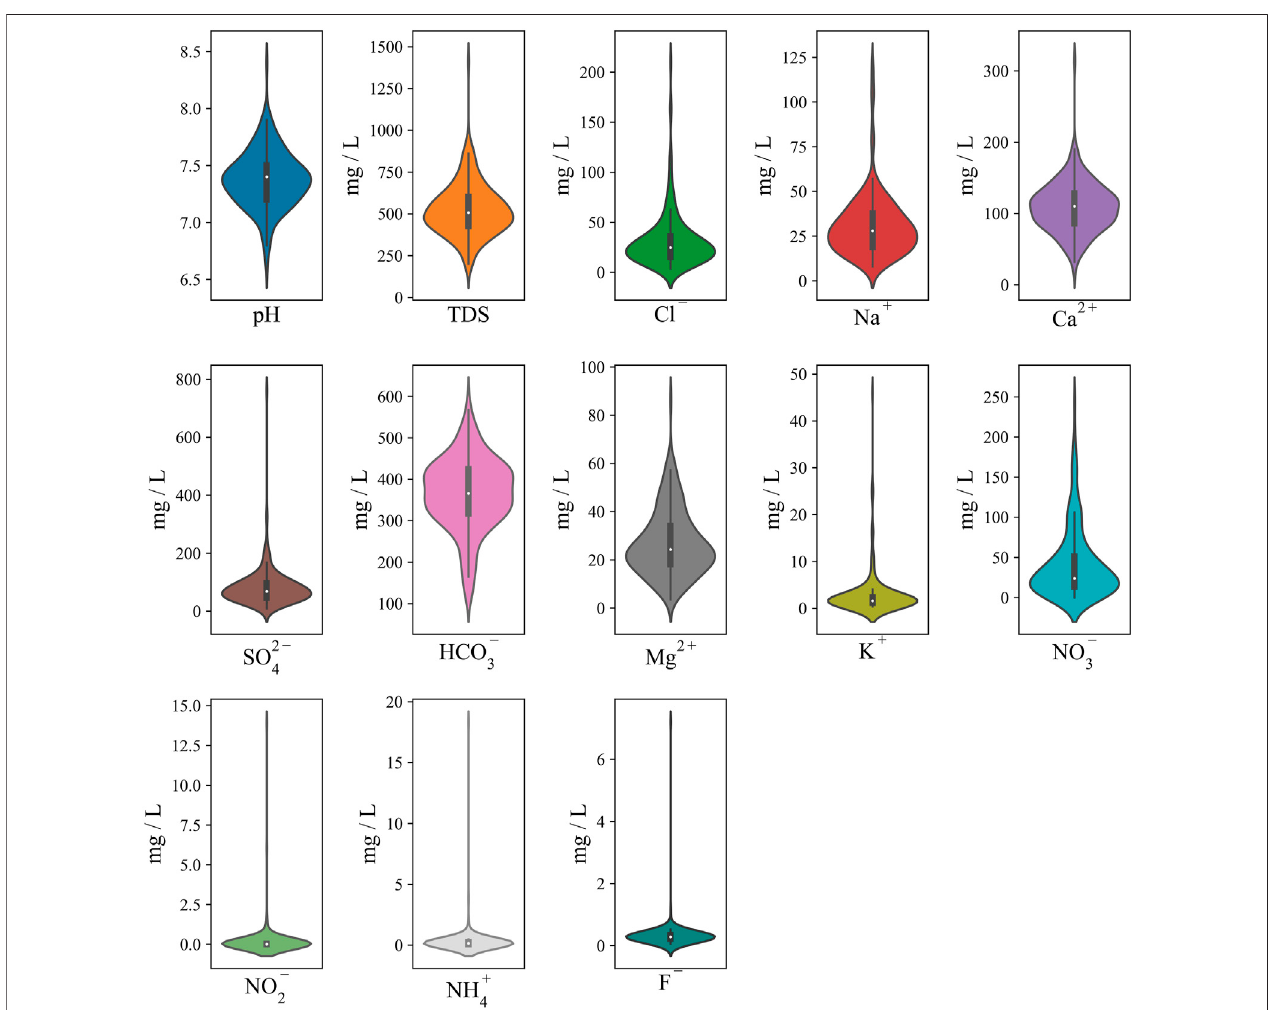
FIGURE 2 | Violin plot of hydrochemical parameters (pH, TDS, anions, and cations).